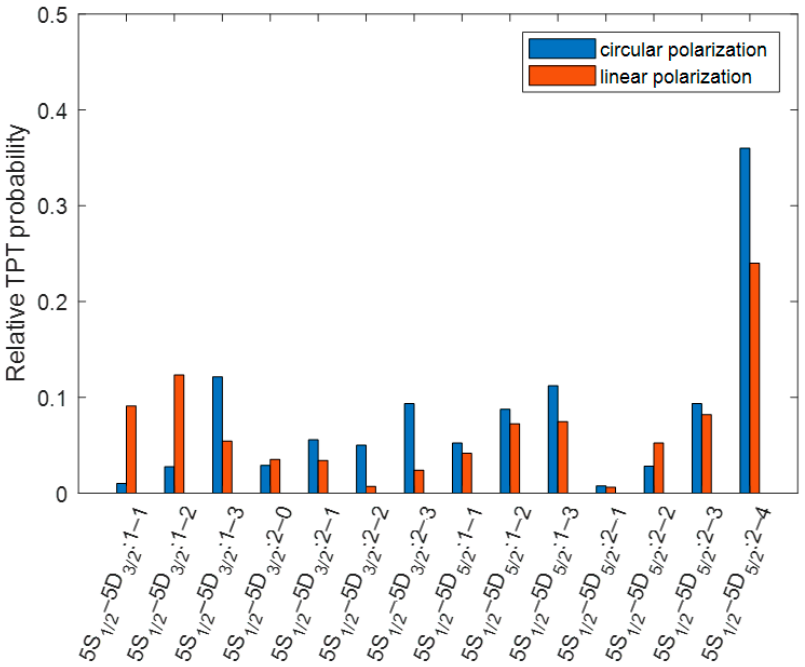
Figure 5. Relative probabilities of 87 Rb 5S-5D two-photon transitions, where blue represents excitation with circularly polarized photons and red represents excitation with linearly polarized photons.